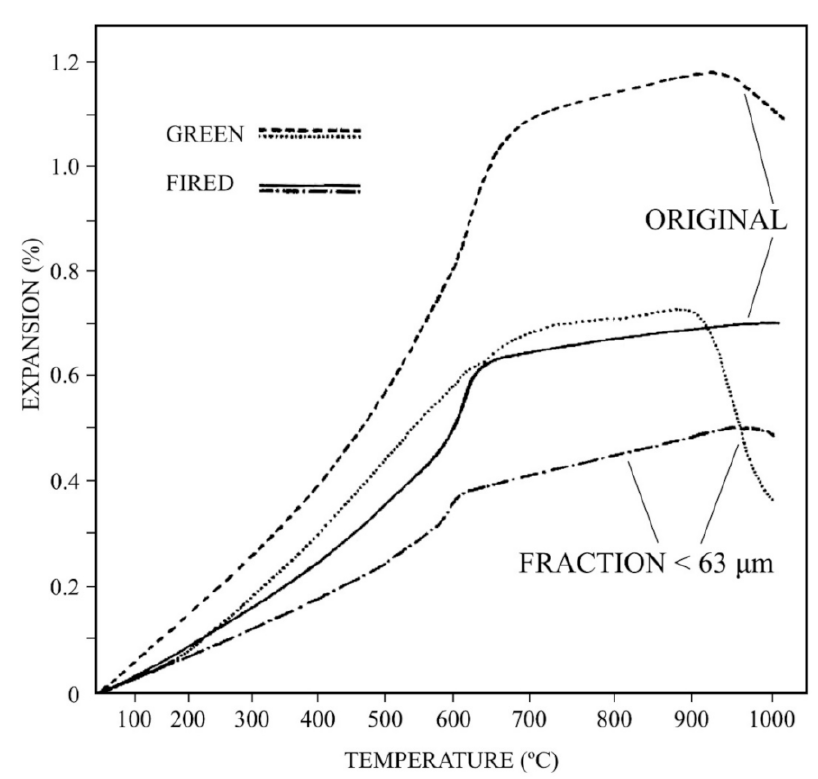
Figure 6. Thermal analysis results by dilatometry (thermal-dilatometry) in green and fired (1000 ◦ C) conditions (heating rate 6 ◦ C/min) of the raw kaolin (labelled as ORIGINAL) and fraction under 63 µ m obtained by wet